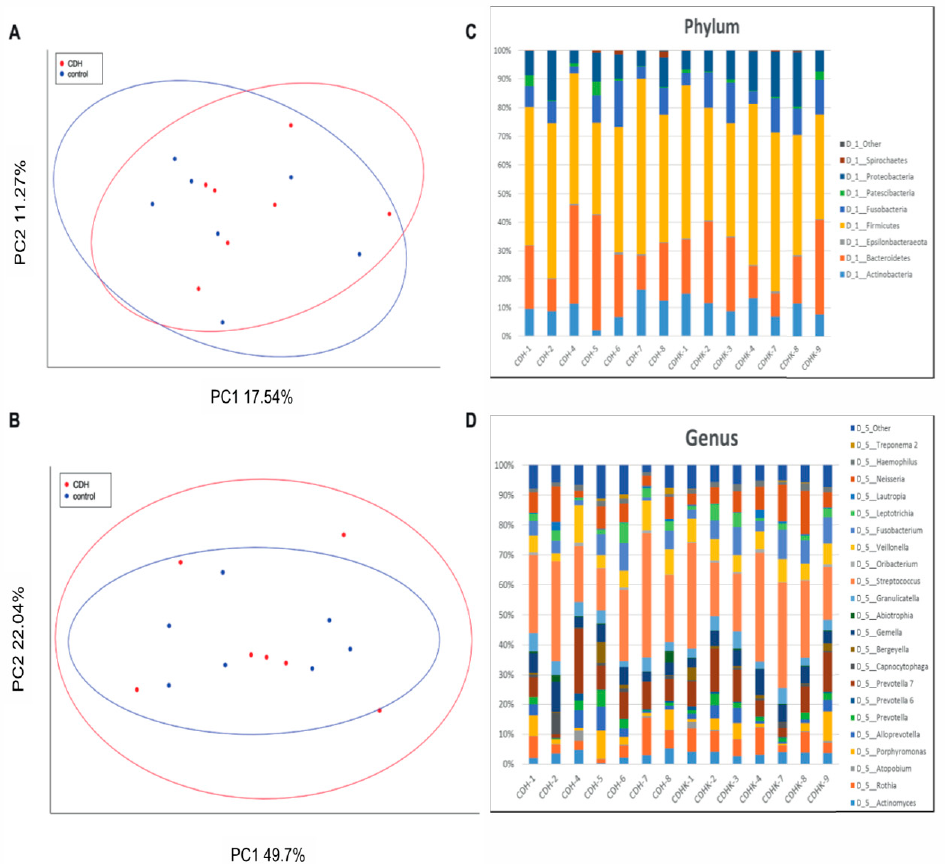
Figure 2. Principial coordinate analysis (PCoA) with weighted UniFrac comparison ( A ) and Bray– Curtis dissimilarity ( B ) tests; 95% confidence ellipses are indicated. The results revealed no obvious clustering of the14 deep induced sputum samples (CDH patients red dots, controls blue dots). PERMANOVA revealed no significant differences in both tests. Relative abundances of CDH patients and age and sex-matched controls at the phylum level ( C ) and genus level ( D ). Note that only bacteria with relative abundances of more than 1% are depicted.